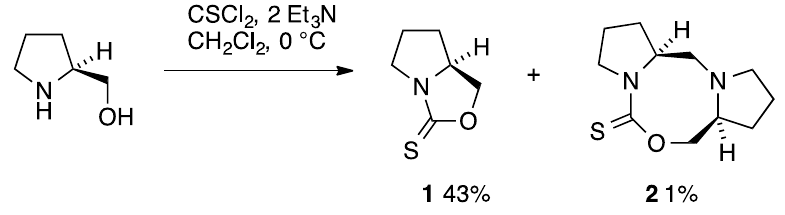
Scheme 1. Synthetic route to 1 and 2.